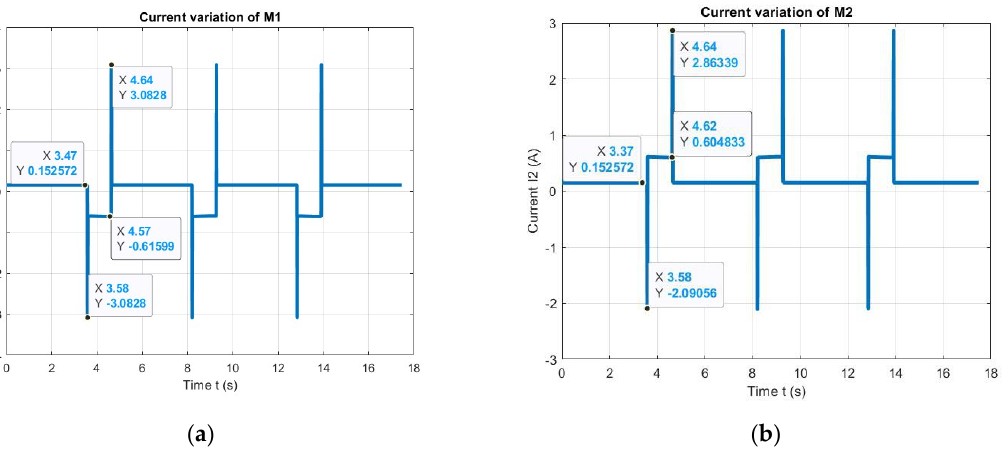
Figure 31. Current variation determined in the model simulation for a 1 m square trajectory. ( a ) Wheel 1 (similar to wheel 3). ( b ) Wheel 2 (similar to wheel 4).